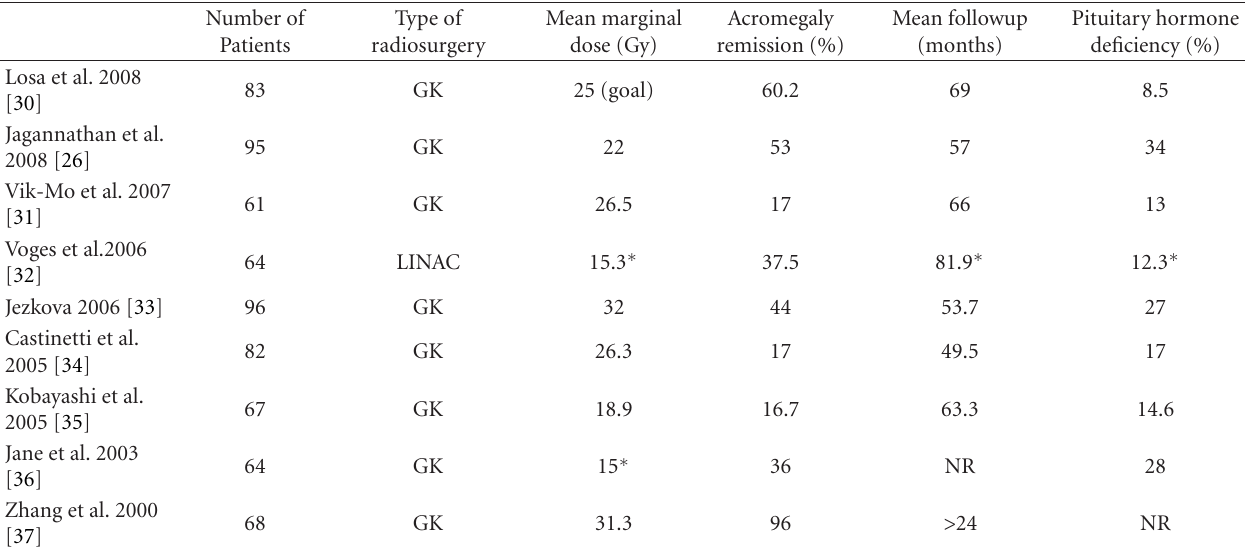
Table 2: Radiosurgery case series including greater than 50 acromegalic